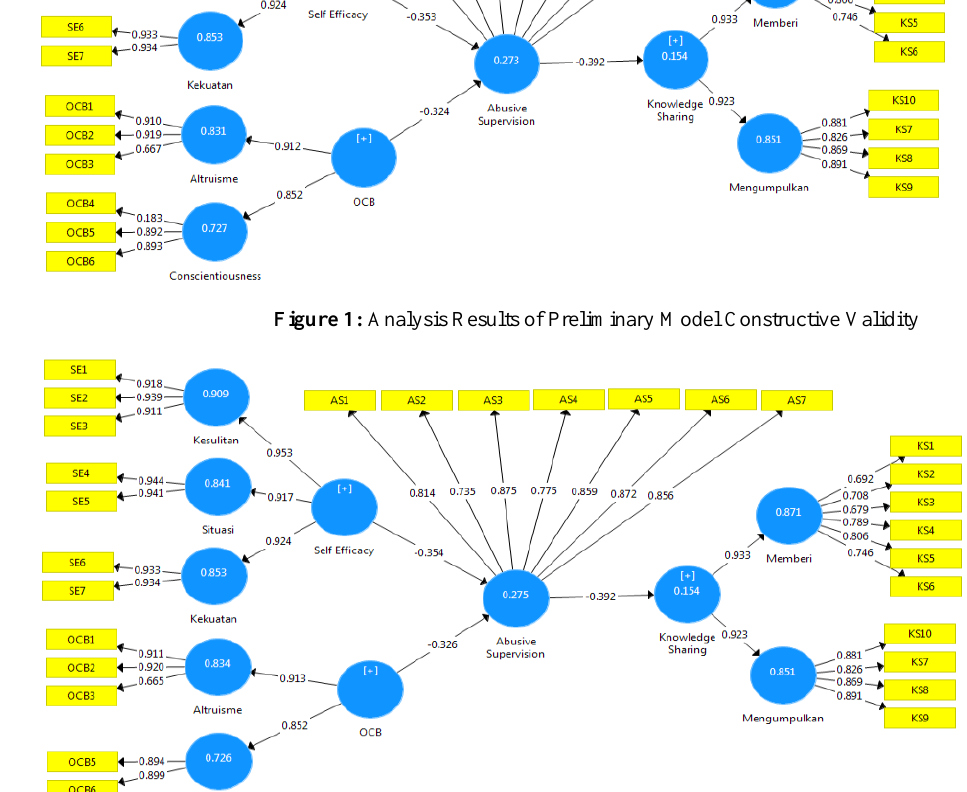
Figure 2: Results of Convergent Validity After